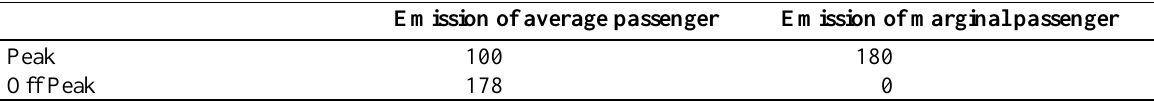
Table 5. Estimation of environmental effects of average and marginal railway passenger (index = 100 for average peak